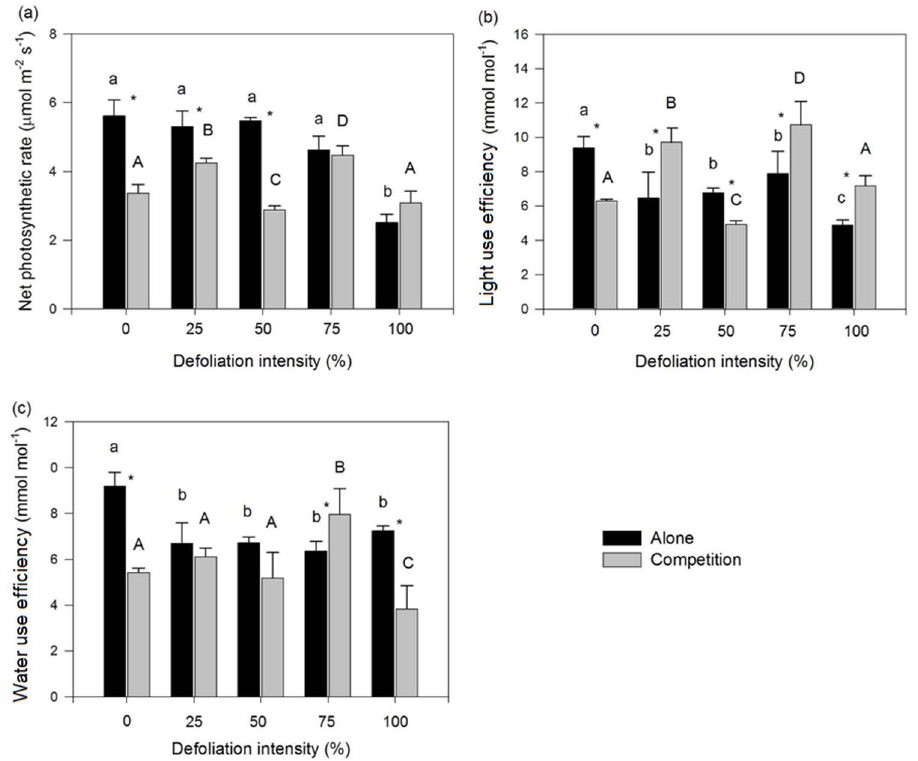
Figure 2. Effect of defoliation and competition on the net photosynthetic rate (a), light use efficiency (b) and water use efficiency (c) of invasive Mikania micrantha . Values are means 6 standard deviation. The different lowercase and uppercase letters indicate significant differences ( p , 0.05 ) among the different intensities of defoliation of invasive Mikania micrantha growing with and without native competitor, respectively. * indicates significant differences ( p , 0.05) between the treatments with or without competitor.